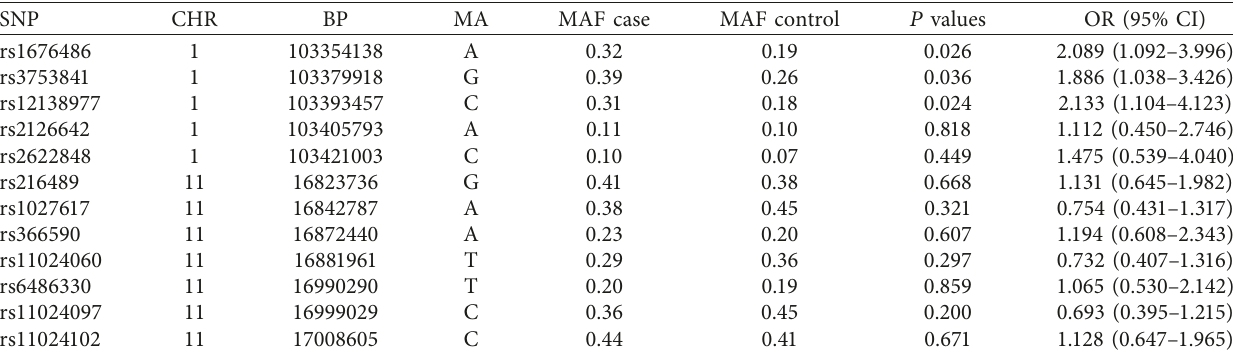
Table 3: Single-nucleotide polymorphism allele frequencies and associations for 12 SNPs between cases and